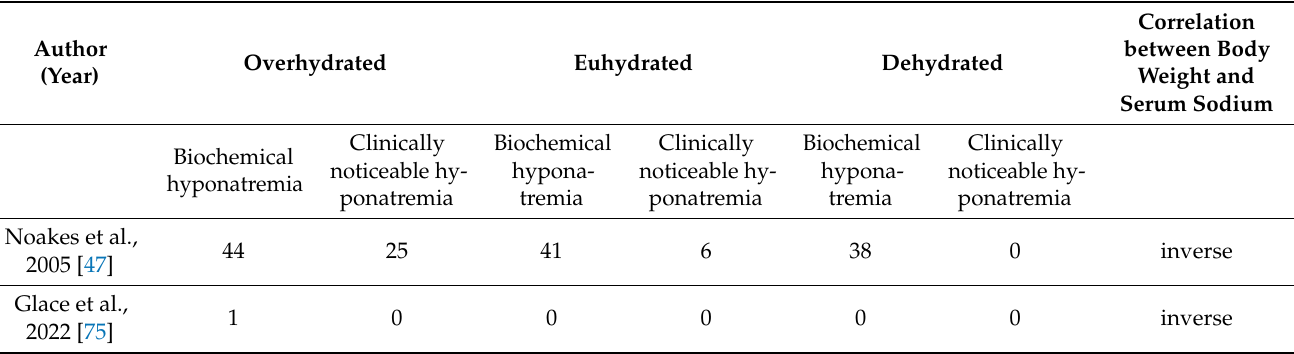
Table 3. Hydration characteristics of participants in the studies from Noakes et al. [47] and Glace et al.